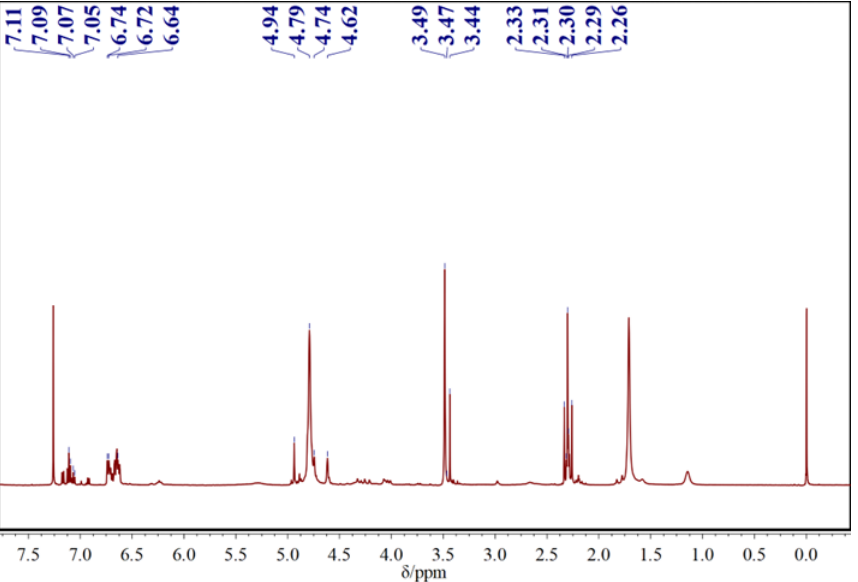
Figure 6. The 1 HNMR spectra of m-cresol formaldehyde resin with a molar ratio of 1/2.0.